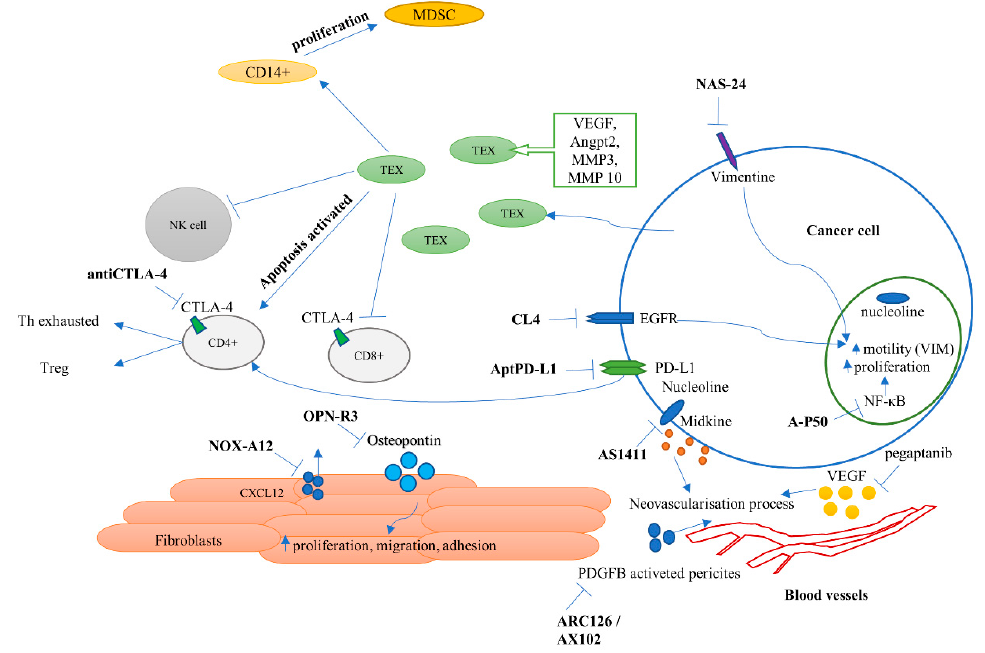
Figure 1. Molecular targets and biological role of mentioned aptamers in the cancer microenvironment.